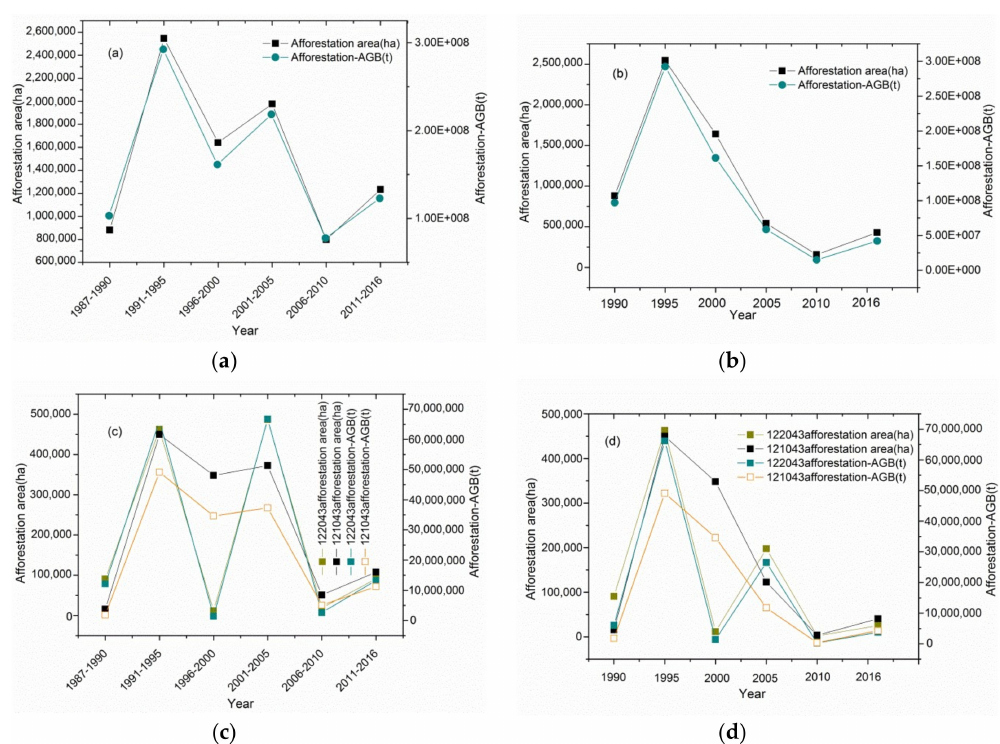
Figure 10. Analysis of the relationship between afforestation and forest AGB change in Guangdong Province (a, b); including northern Guangdong: p122r043, p121r043 (c,